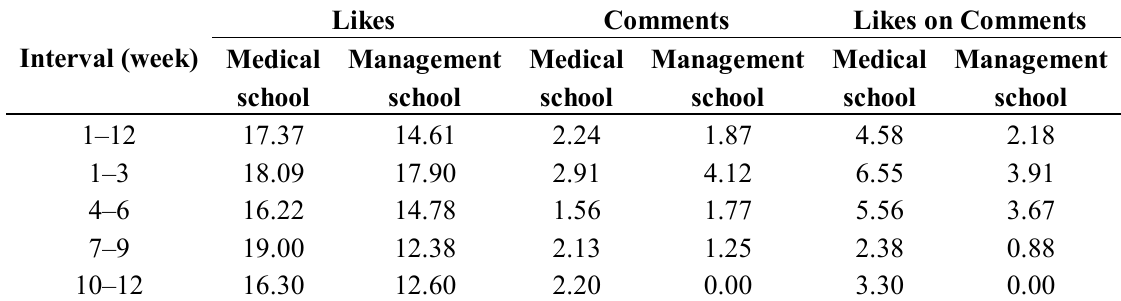
Table 3. The average engagements and influence by 3-week interval.